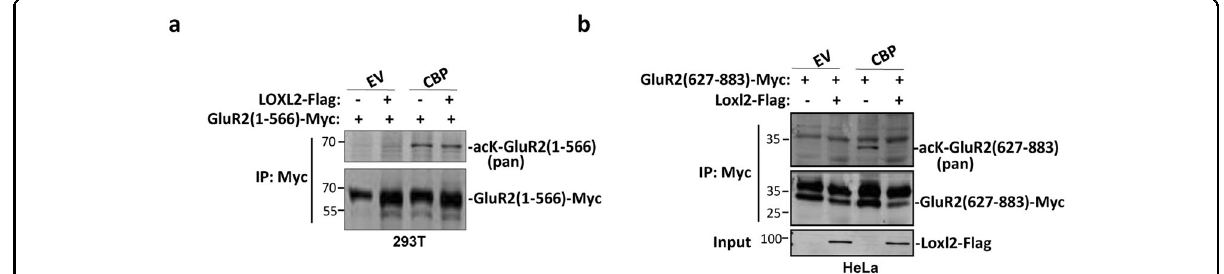
Fig. 2 GluR2 is deacetylated by Loxl2. a , b 293 T cells were transfected with indicated plasmids. Cells were subjected to immunoprecipitation with Myc antibody followed by western blot with pan-acetyl and Myc